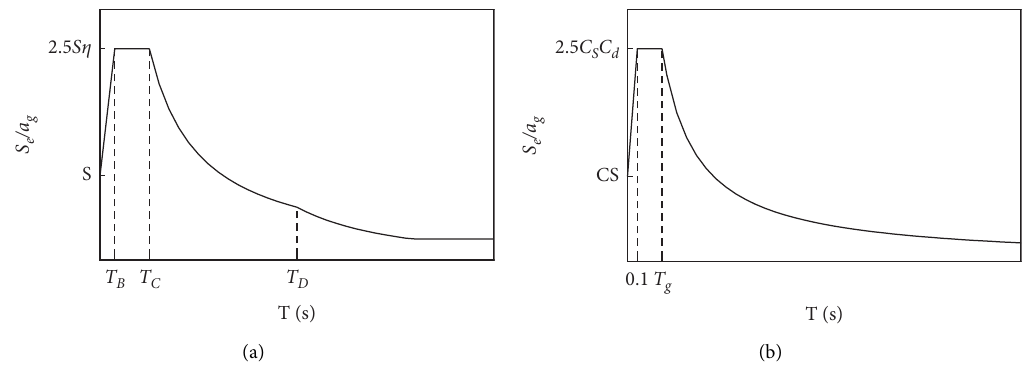
Figure 1: Basic shape of horizontal elastic response spectra: (a) Eurocode 8 and (b) the Chinese specification. Table 1: Values of the parameters describing the basic shape of the horizontal elastic response spectra. Eurocode 8 Chinese specification Ground